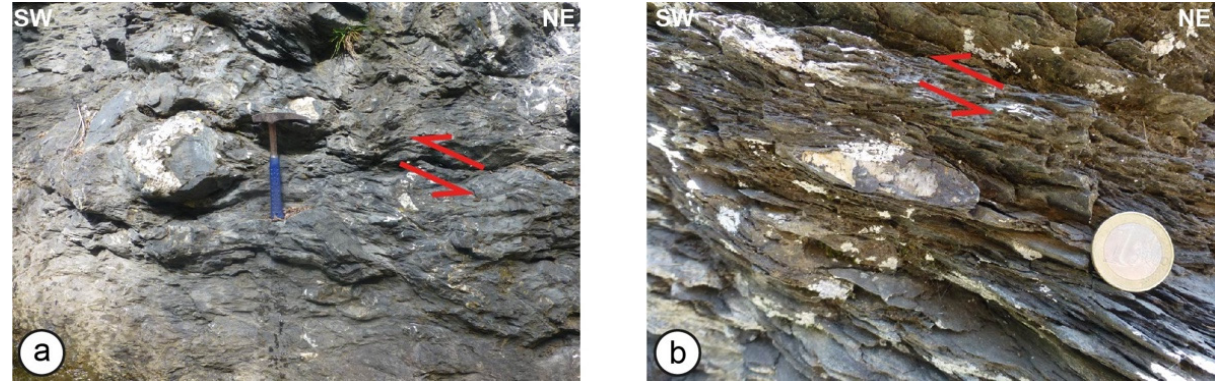
Figure 7. Mesoscopic view of the lower ( a ) and upper ( b ) unit-bounding thrust systems. The red arrows indicate the sense of movement.